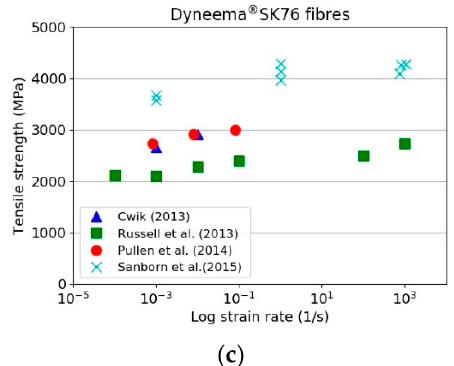
Figure 2. Tensile strength of Dyneema ® HB26 laminates as function of: ( a ) Strain rate; ( b ) Thickness; ( c ) Tensile properties of Dyneema ® SK76 fibres.